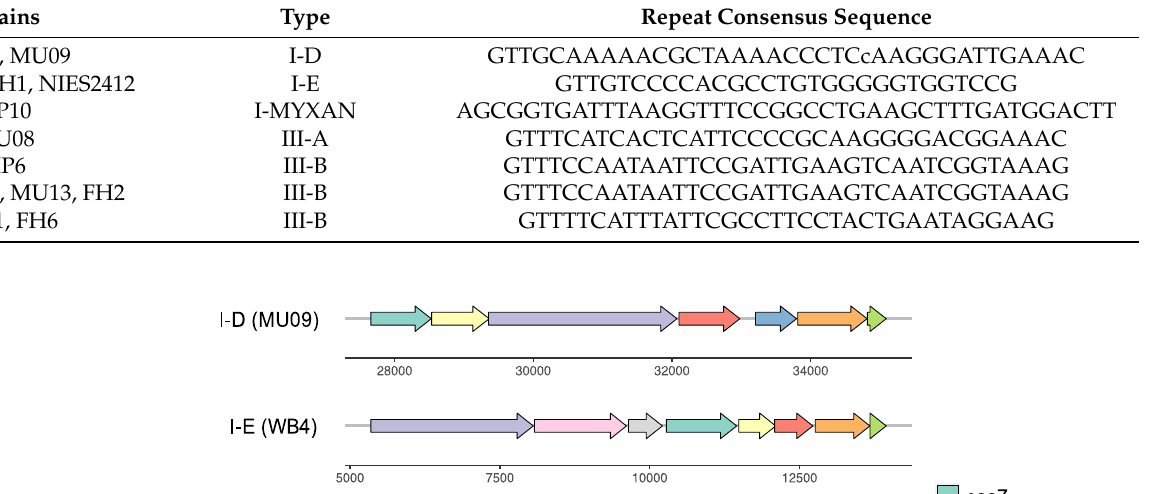
Table 1. CRISPR-Cas systems detected in A. marina genomes.